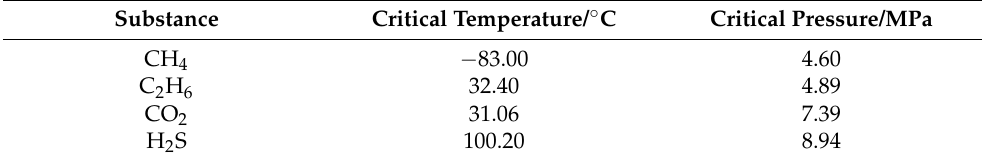
Table 1. Critical data table of common supercritical fluids in carbonate sour gas